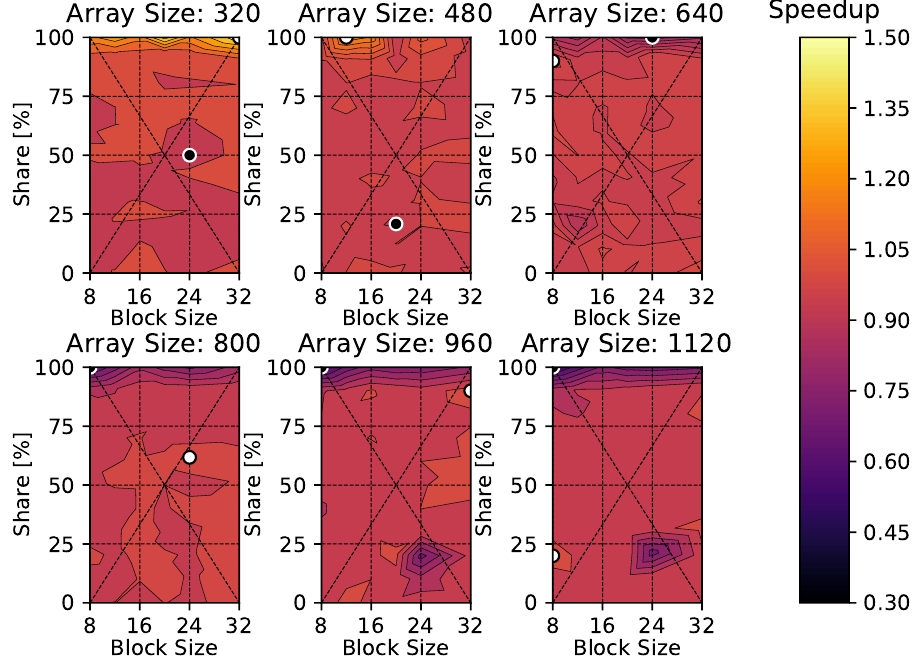
Figure 8. Swept rule speedup results for the compressible Euler equations with Tesla V100-DGXS-32GB GPUs and Intel E5-2698v4